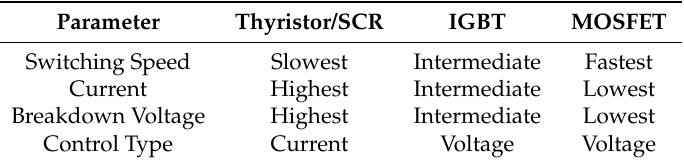
Table 3. Comparison of characteristics of selected solid-state switch types. Note that the designations in this table are for individual switches and not for arrays containing multiple